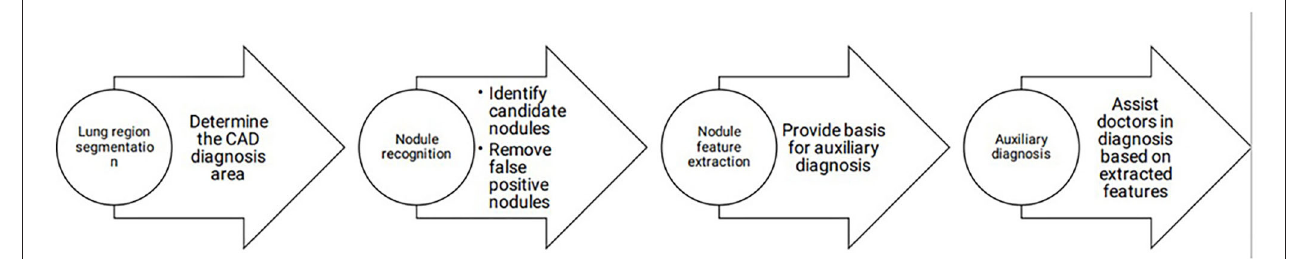
FIGURE 1 | CAD workflow.